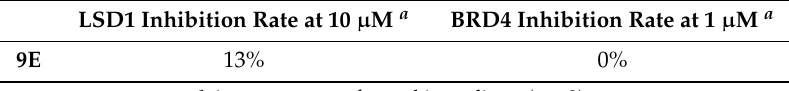
Table 4. Lysine specific demethylase 1 (LSD1) and BRD4 inhibition results of 9E